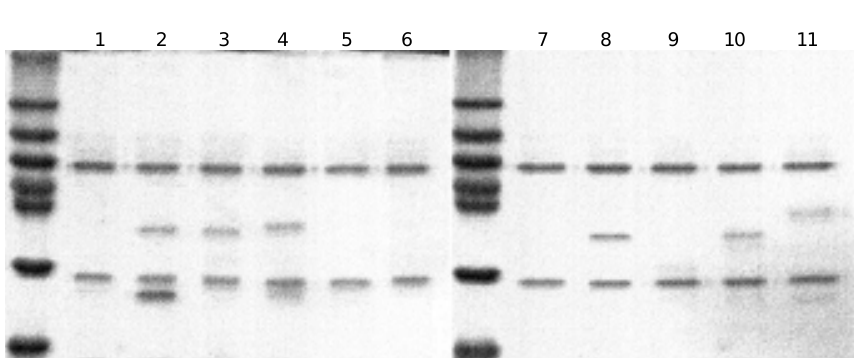
Figure 5 - SDS-PAGE (12% acrylamide) of immunoprecipitated venom proteins of Bothrops species by 6AD2-G5 immobilized on Sepharose-4B. Bands close to the 55,000 and 31,000 markers, present in all slots, are the heavy and light IgG fractions. The amounts of venom used in the immunoprecipitation experiments are given in parentheses. Lane 1 , B. fonsecai (0.41 mg); lane 2 , B. leucurus (0.58 mg); lane 3 , B. pradoi (0.41 mg); lane 4 , B. jararaca (0.54 mg); lane 5 , B. insularis (0.28 mg); lane 6 , B. cotiara (0.25 mg); lane 7 , B. alternatus (0.33 mg); lane 8 , B. neuwiedii (0.33 mg); lane 9 , B. jararacussu (0.33 mg); lane 10 , B. moojeni (0.30 mg); lane 11 , B. atrox (0.64 mg).